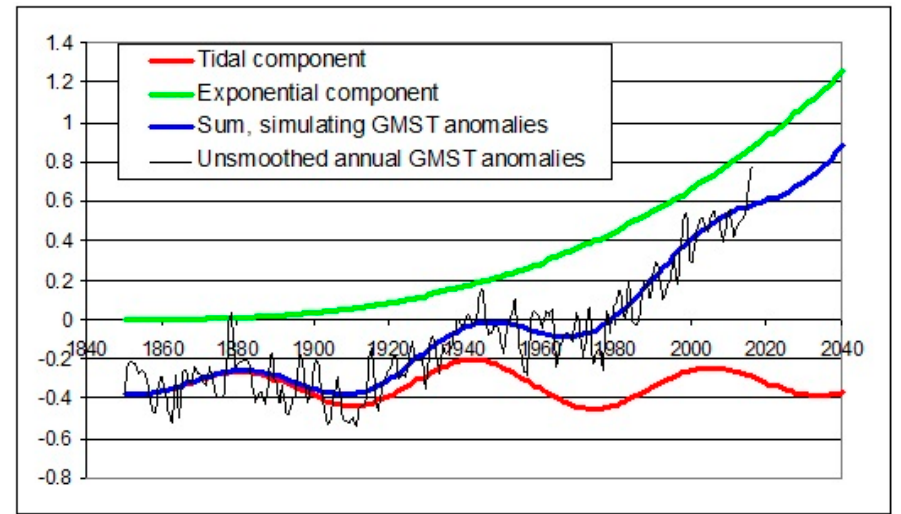
Figure 3. Adding tidal and exponential components to simulate annual unsmoothed HadCRUT4 global mean surface temperature (GMST) anomalies, the curves projected to 2040.